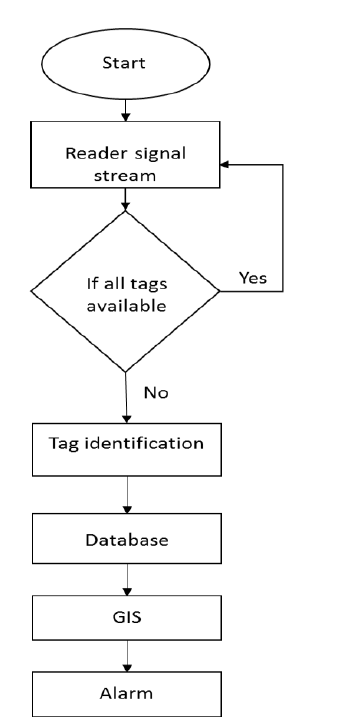
Figure 1. Jewellery security system